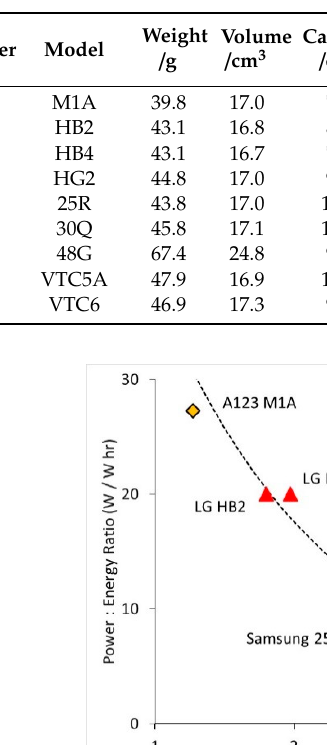
Table 4. Measured and calculated properties of cells.